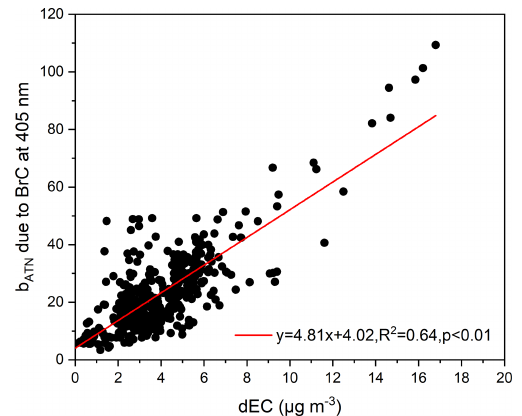
Figure 3. Relationship between the b ATN , due to BrC at 405nm, and the dEC